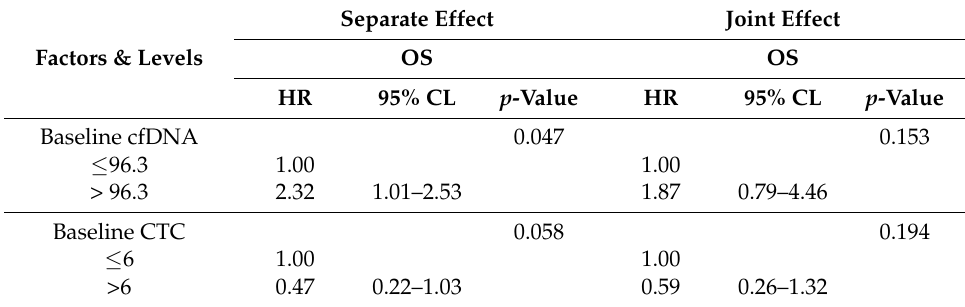
Table 4. Separate and joint effects of cfDNA and CTCs on overall survival probabilities estimated using the Cox multiple regression modeling in patients with stable disease at best overall